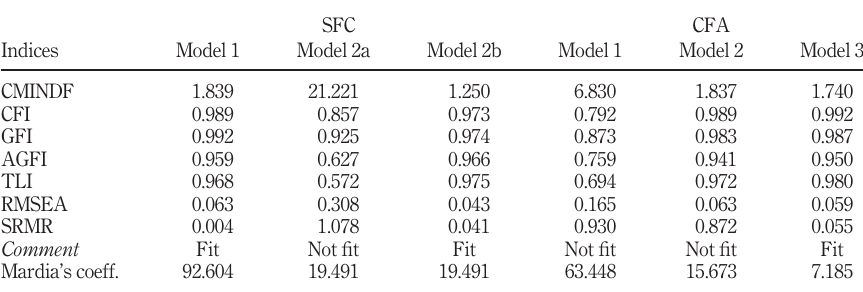
Table 4. Goodness-of- fi t indices and Mardia ’ s